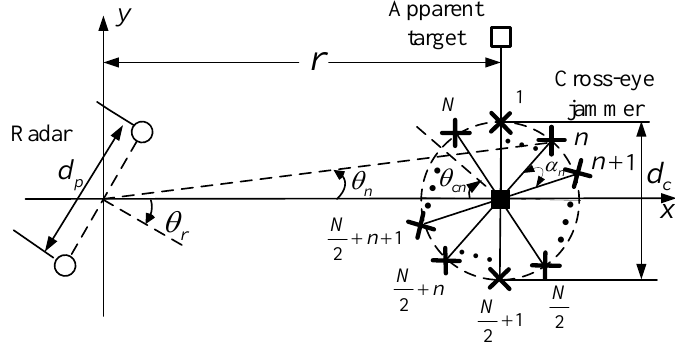
Figure 2. The jamming geometry where C-MRCJ deceives a phase-comparison monopulse